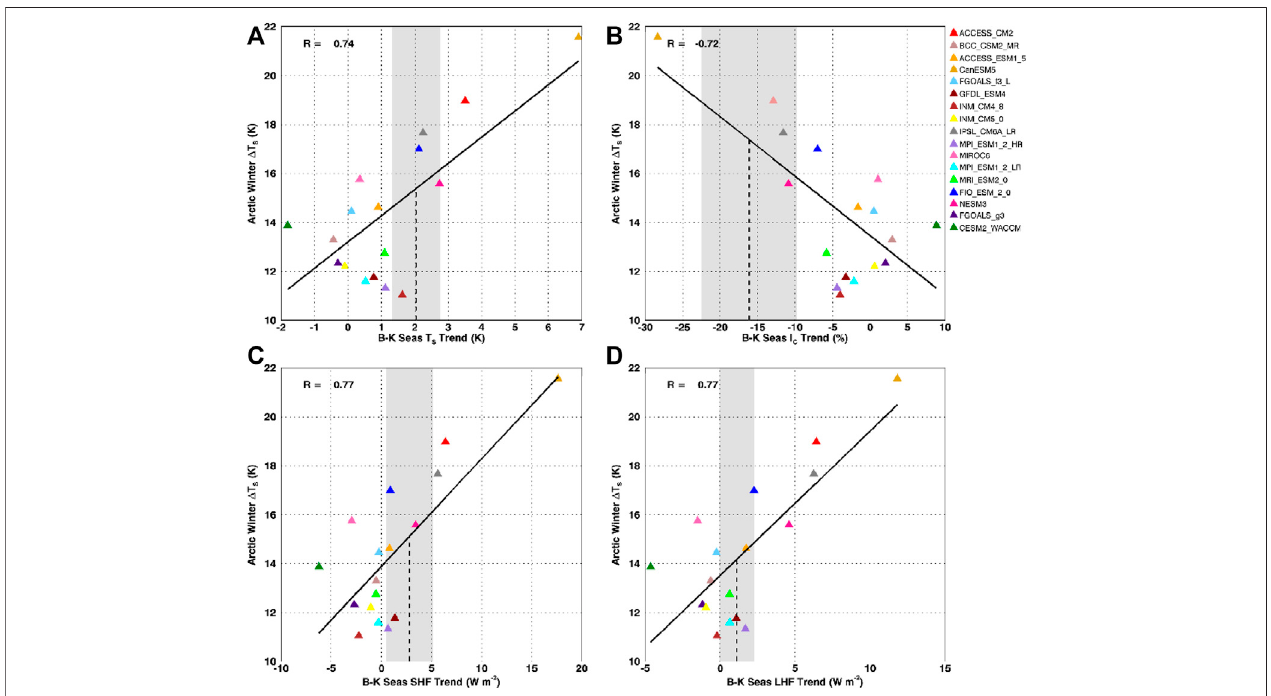
FIGURE 10 | Barents-Kara Seas present-day trends for sea ice gridboxes ( > 15% I C ) in (A) T S , (B) I C , (C) SHF and (D) LHF correlated with projected Arctic winter (ONDJ) warming. CMIP6 models are colored triangles while the dashed line indicates the present-day trend found for observations with the grey shading ± the observational standard